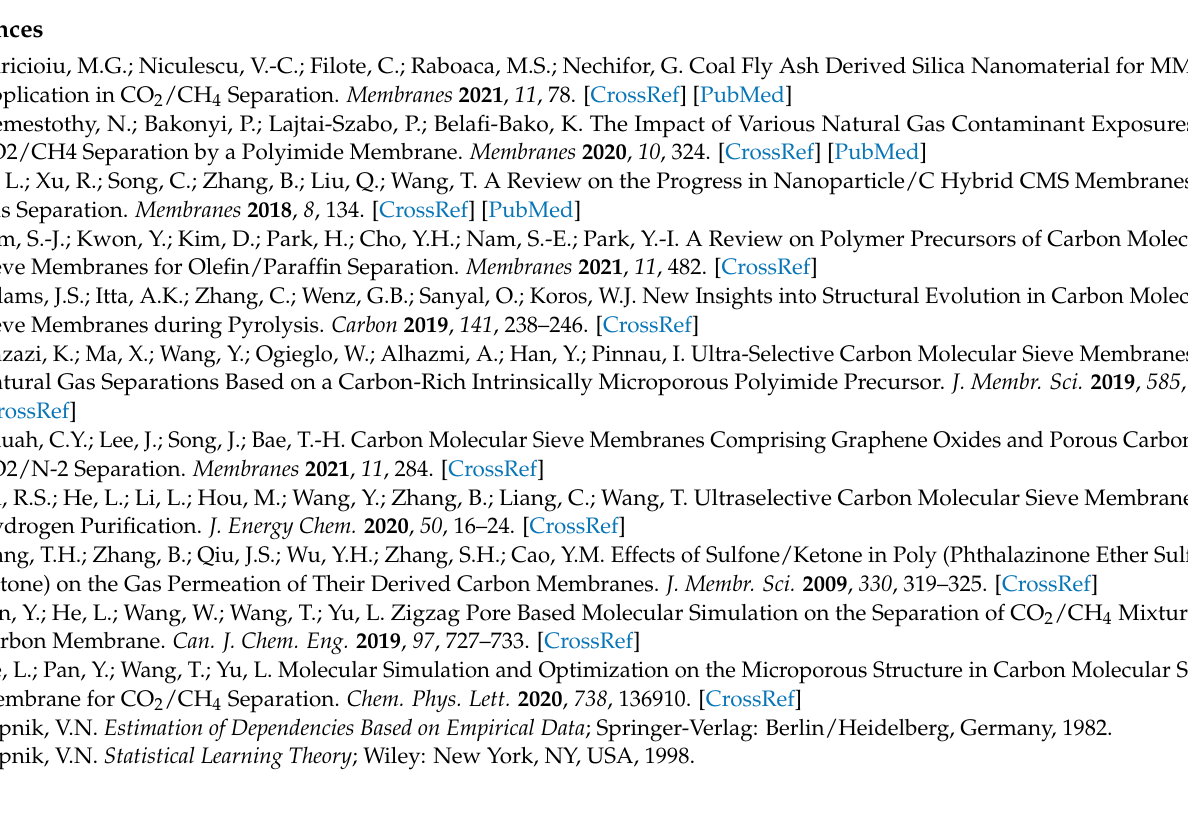
cursors, Figure S2: Calculation of fractional free volume (FFV),Figure S3: Calculation of carbon structural parameters, Figure S4: Calculation of gas-carbon interaction, Tables S2 and S5: Parameters of gas pairs in the Robeson upper bound, Figure S6: The kernel functions used in the support vector regression, Figures S3 and S7: Variation of the statistical coefficients with the parameters of the kernel